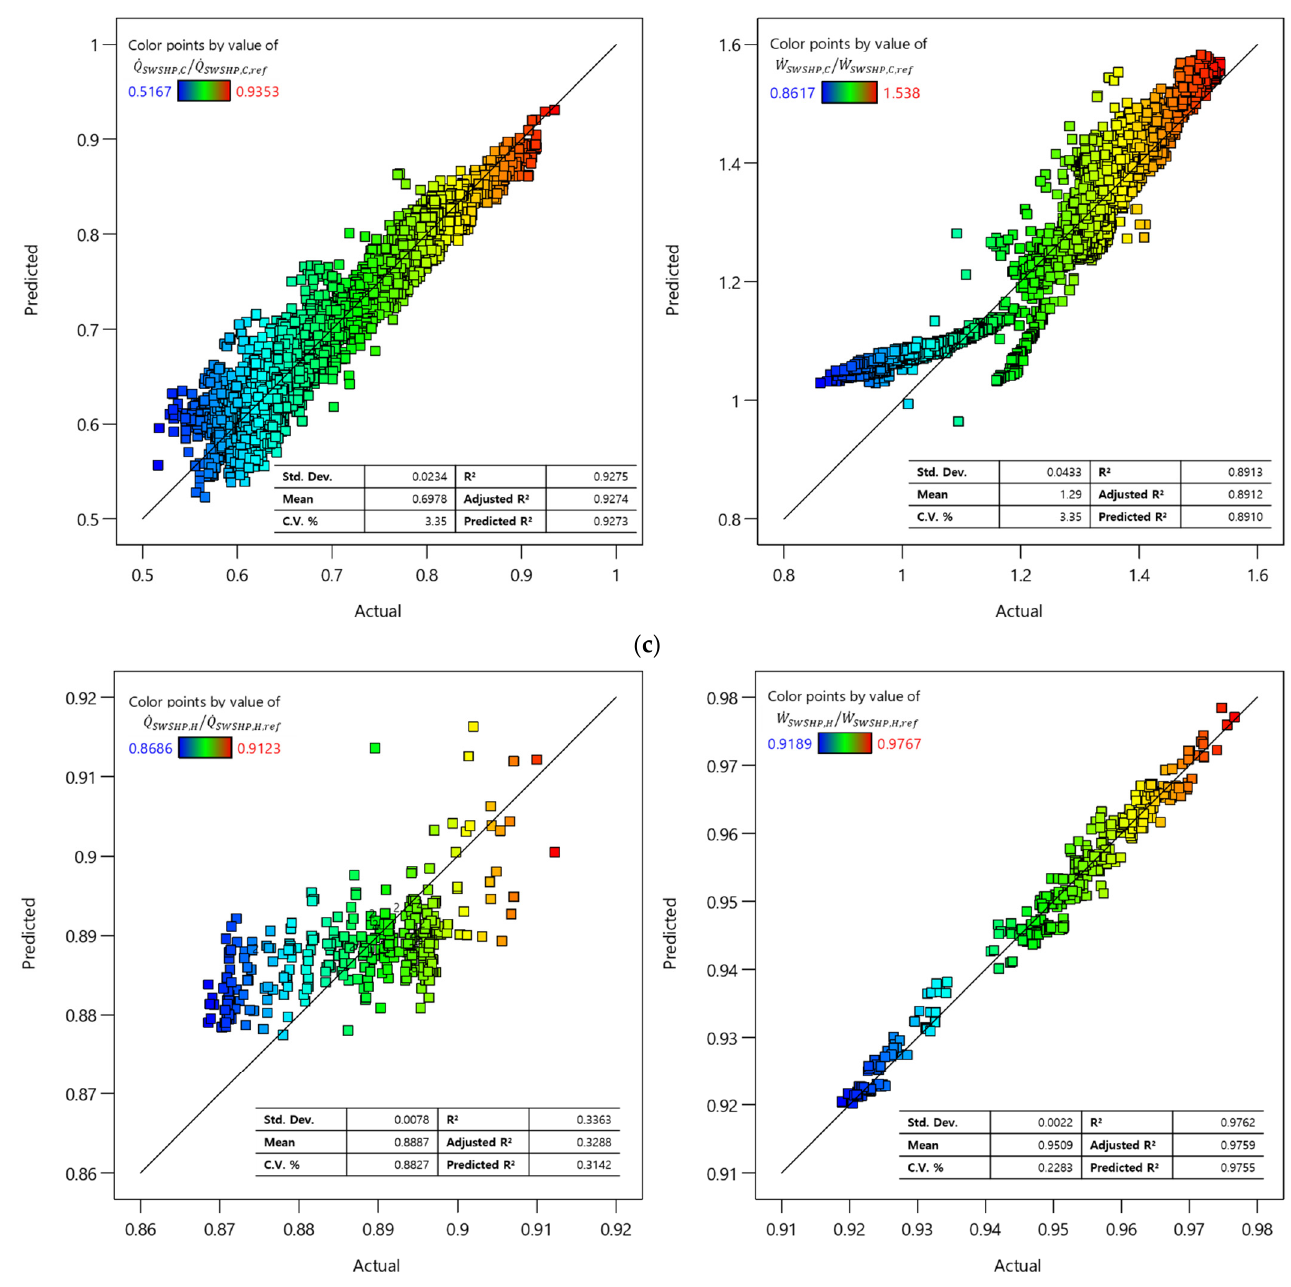
Figure 10. Comparison of the predicted model with experimental results: ( a ) GSHP cooling mode operation model; ( b ) GSHP heating mode operation model; ( c ) SWSHP cooling mode operation model; and ( d ) SWSHP heating mode operation model.